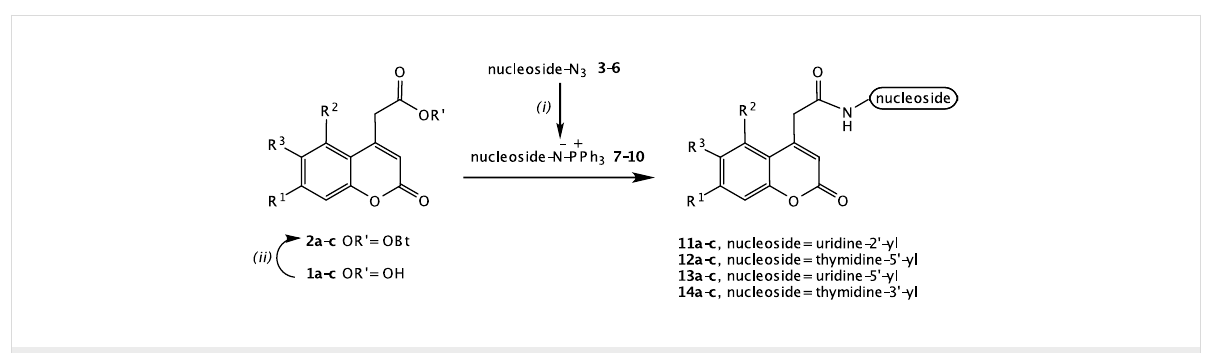
Scheme 1: Preparation of coumarin labeled nucleosides, (i) PPh 3 , acetonitrile, (ii) HOBT, DCC,